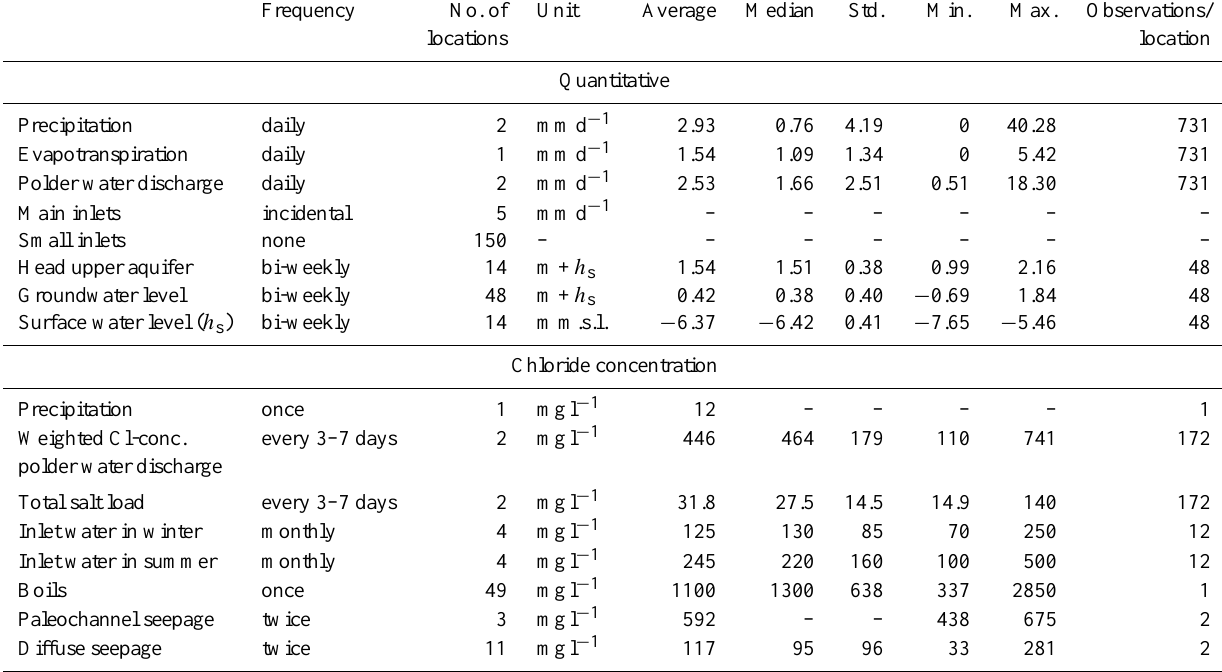
Table 1. Summary of monitoring data of Noordplas Polder for period 1 August 1999 up to 1 August